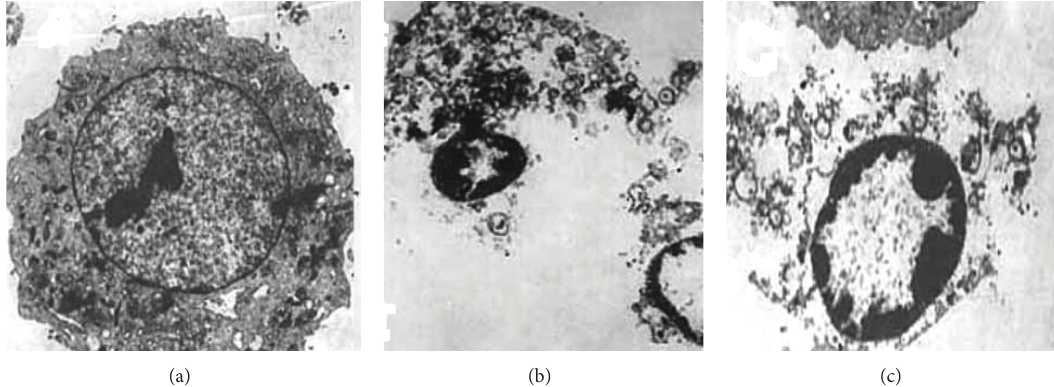
Figure 3: Ultrastructural changes associated with the necroptotic cell death induced by a combination of TNF- 𝛼 (10ng/mL) and z-VAD-fmk (20 𝜇 M) in NHI3T3 murine fibroblasts (a diploid cell line). Panel (a) shows a cell with intact organelles and plasma membrane, whereas (b) shows cells with extensive cytoplasmic degeneration and plasma membrane rupture and (c) shows a cell with apoptosis-like chromatin condensation.